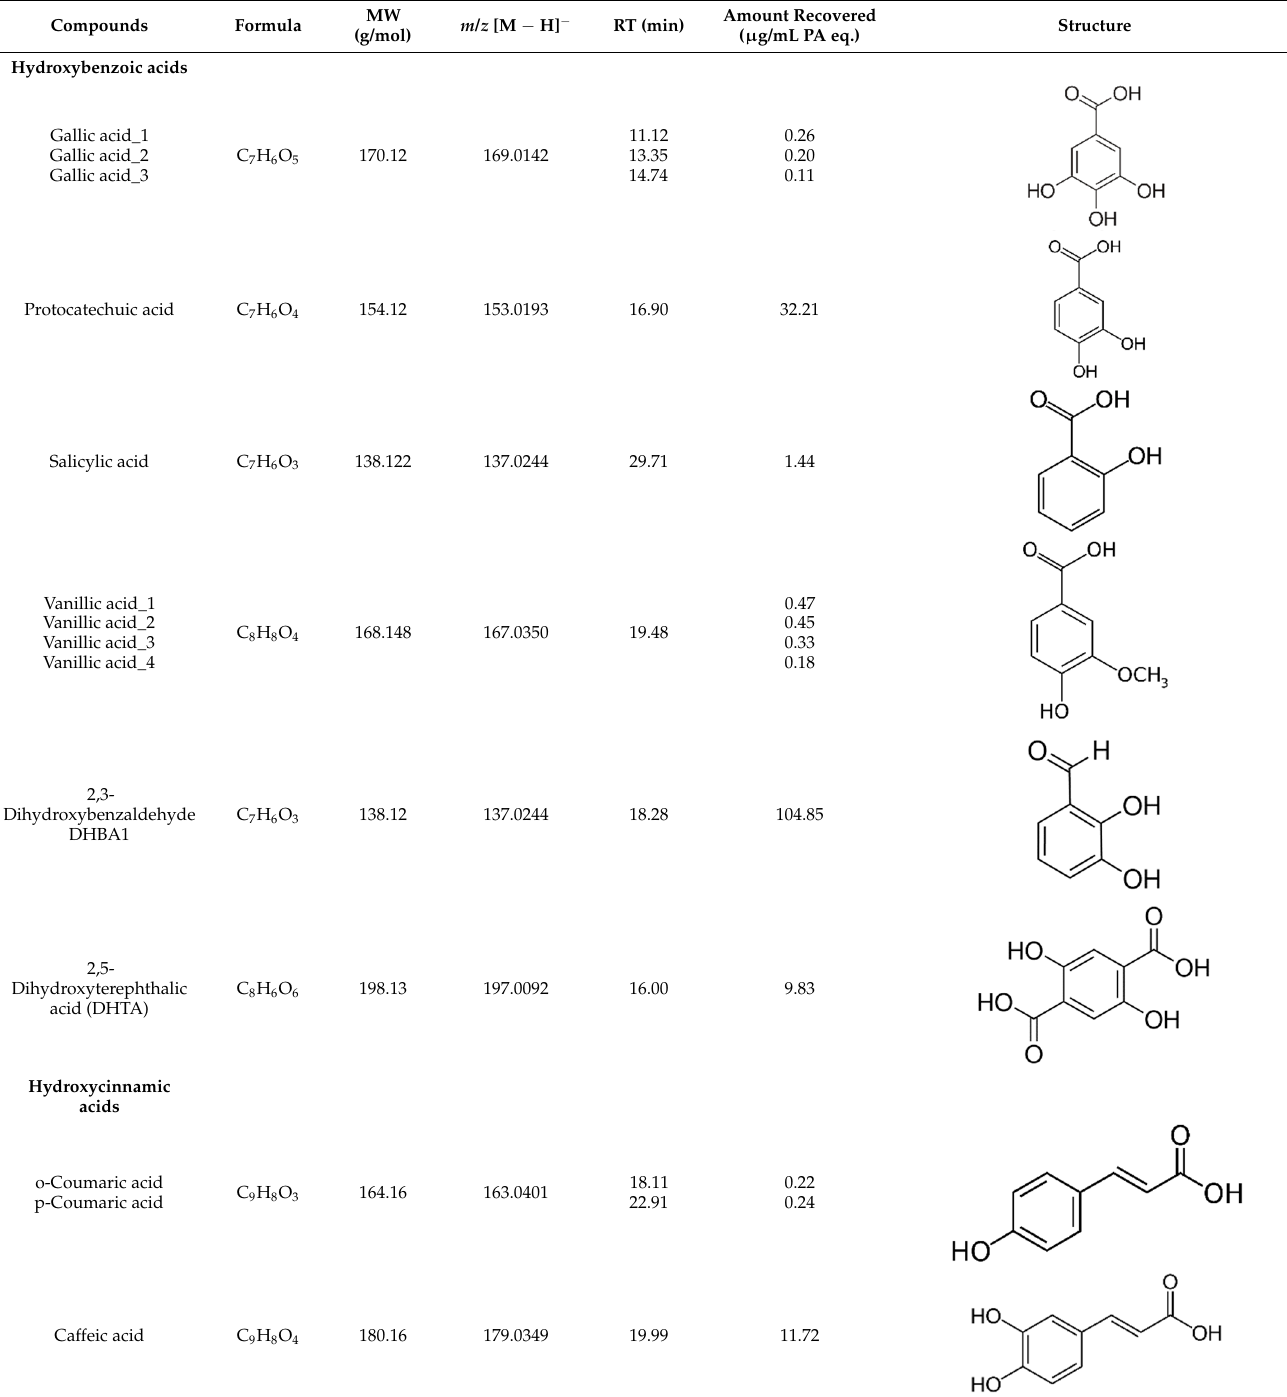
Table 2. Phenolics content (µg·g − 1 dry weight) in Inonotus obliquus extracts obtained under different pH and temperature conditions.